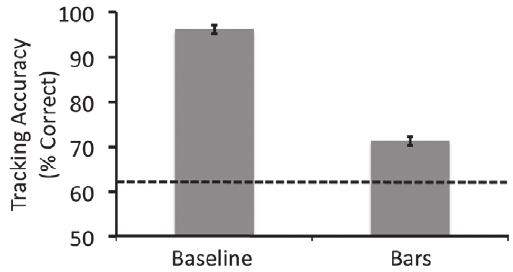
Figure 3. Results from Experiment 1 for the two conditions. The dotted line represents the expected performance level had the observers been able to track only one of the four targets and had to guess where the other three targets were located.